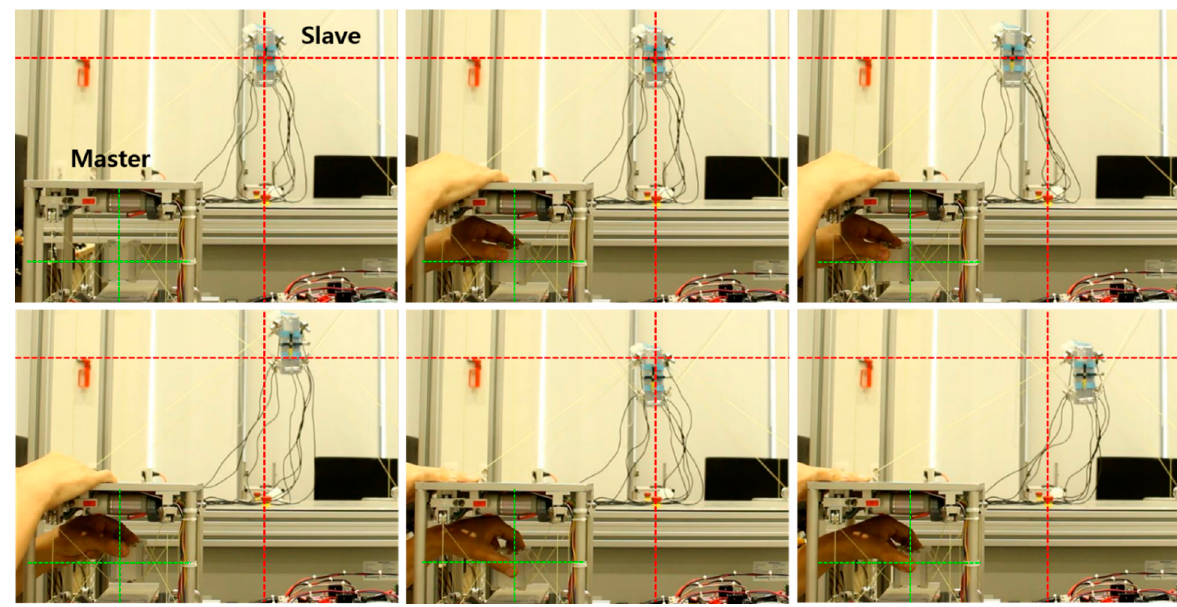
Figure 11. Snapshot of the master–slave teleoperation system experiment.